Question: Condense the content of this figure into a single sentence.
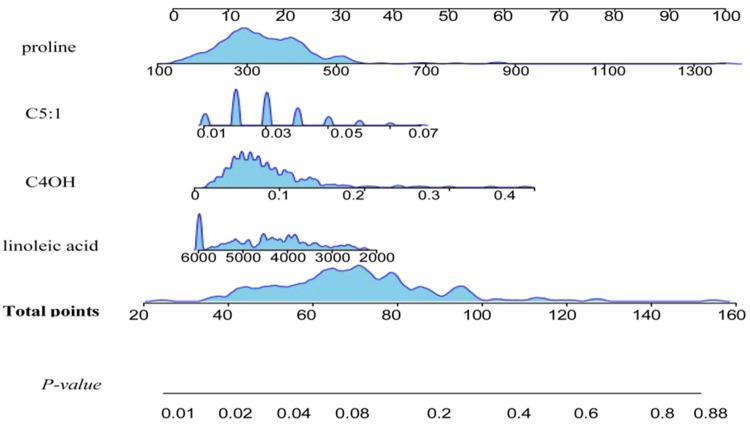
Answer: Nomogram of four independent predictors based on logistics regression. The nomogram displays the score allocated to each independent risk factor.